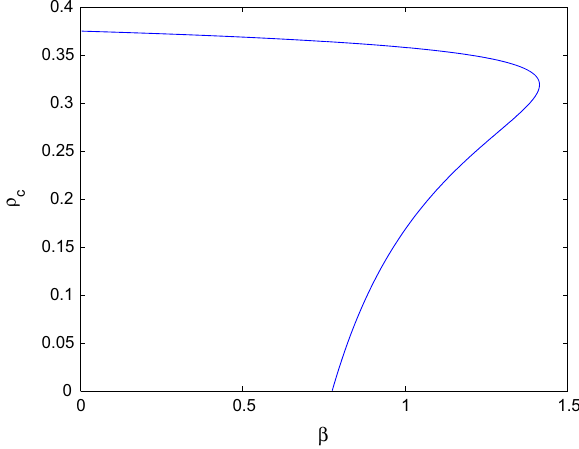
Fig. 6 The plot of the function P vs v at q m = β = 1. The critical isotherms correspond to T c1 = 0 . 0402936 and T c2 = 0 . 0448542